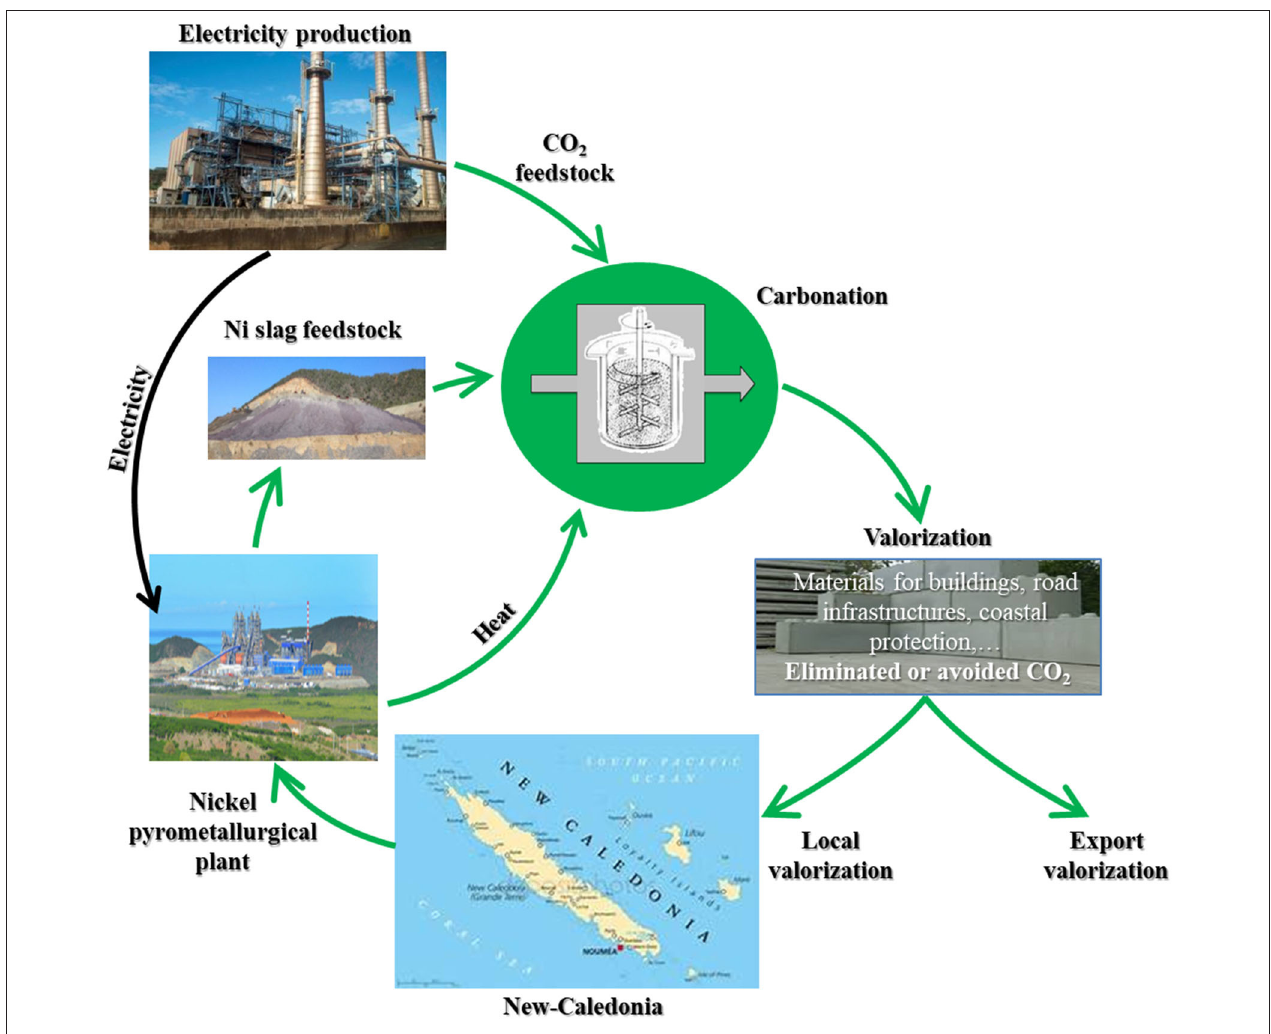
FIGURE 4 | Vision of integrated CO 2 mineralization in New-Caledonia.